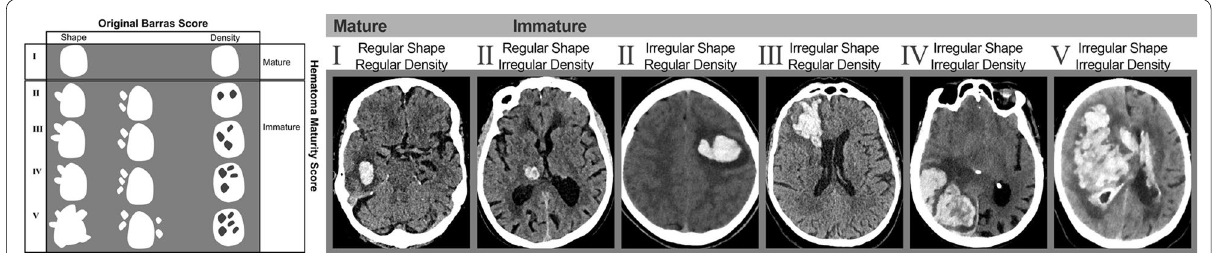
Fig. 5 Hematoma Maturity Score. Examples of the two categories of Hematoma Maturity Score. Categories of Hematoma Maturity Score classified ICH as mature (completely homogeneous in density and shape) and immature (ICH with any irregularity in density or shape) illustrated by typical cases. Categories of the Barras score classified ICH as homogenous and regular if the Barras score was < 4, and heterogenous and irregular if the original Barras score of the variables was 4. The left panel illustrating the score is adopted from the original publication by Serrano et al. [112] ≥